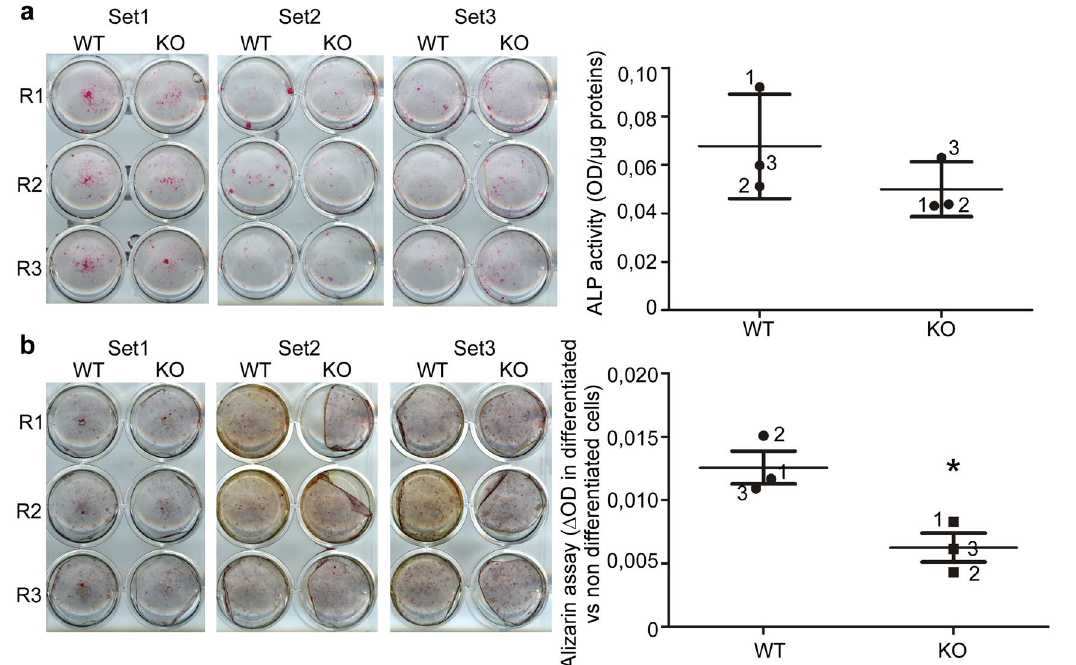
Figure 8. Analysis of the differentiation and activity level of Hyal1 −/− osteoblasts cultured in vitro. Pre- osteoblasts were isolated from calvariae of new-born mice. Three independent sets, each derived from a pool of minimum 8 different calvariae, and comprising 3 replicates (R1 to R3), were analyzed. Differentiation was induced by supplementation of the culture medium with 50 µg/mL of vitamin C (Day 0 up to Day 14). From Day 15 to Day 21, the cells were cultured in the presence of 50 µg/mL vitamin C and 5 mM β-glycerophosphate. ( a ) Alkaline phosphatase staining of WT and Hyal1 KO cells at Day 14, and measurement of alkaline phosphatase specific activity in cell lysates (Day 14). ( b ) Alizarin staining at Day 21 of differentiation, followed by lysis in NaOH and measurement of absorbance levels at 405 nm. The graphs show mean ± SEM values of the 3 independent sets. * p < 0.05. Paired